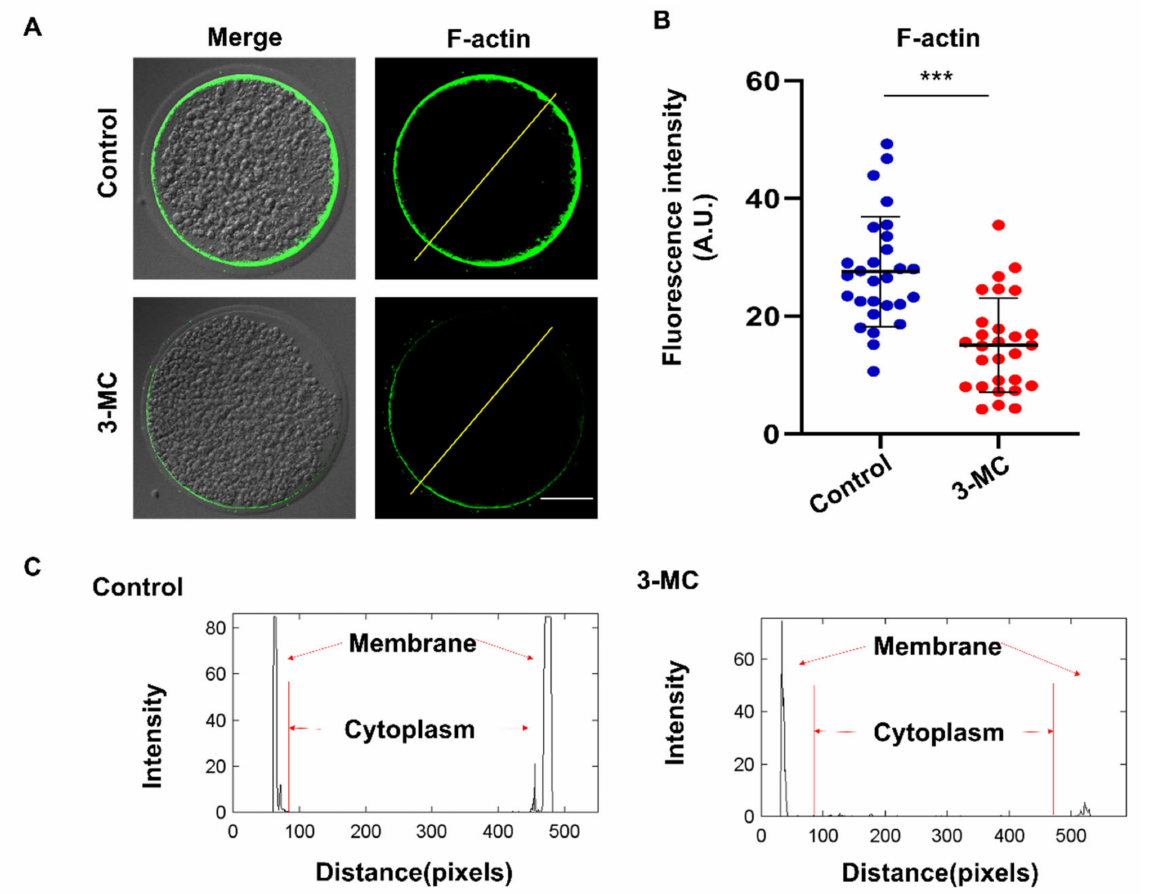
Figure 4. Effects of 3-MC exposure on the actin polymerization in porcine oocytes. ( A ) Representative images of actin filaments in control and in the 100 µ M 3-MC treatment group, scale bar 25 µ M; ( B ) the fluorescence intensity of actin signals was quantitatively analyzed in each group. ( C ) The fluorescence intensity profiling of actin filaments in each group. Lines were drawn through the oocytes, and pixel intensities were quantified along the lines; data were presented as mean ± S.E.M of at least three independent experiments. *** p <